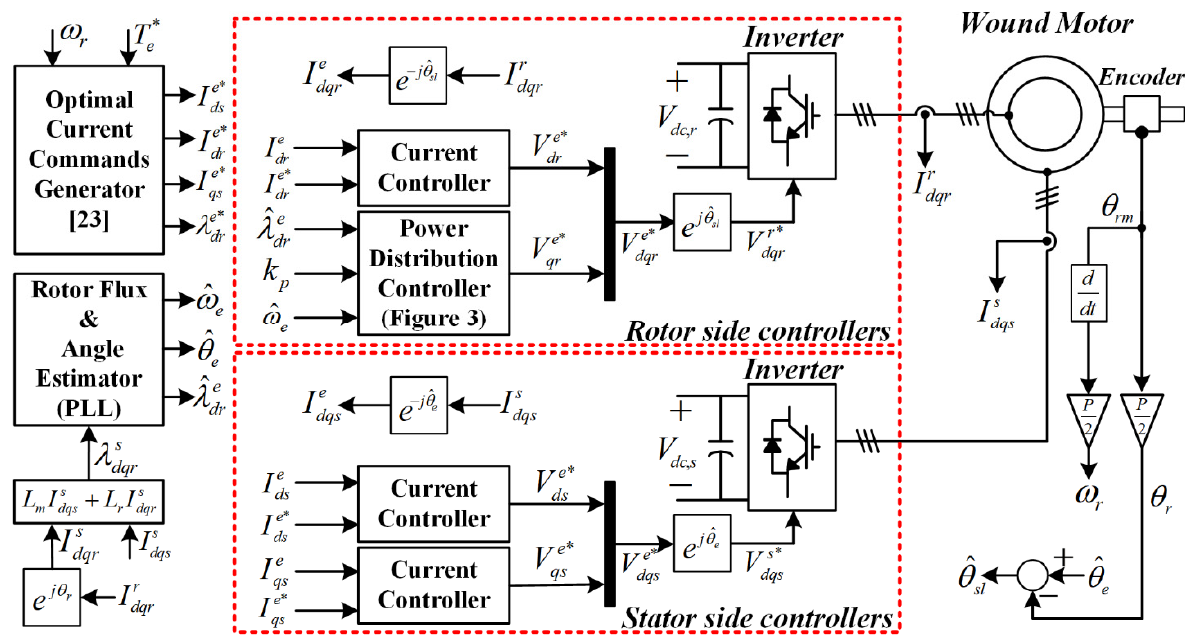
Figure 4. Entire control block diagram of the minimum copper loss control method in a DIFWM [23].